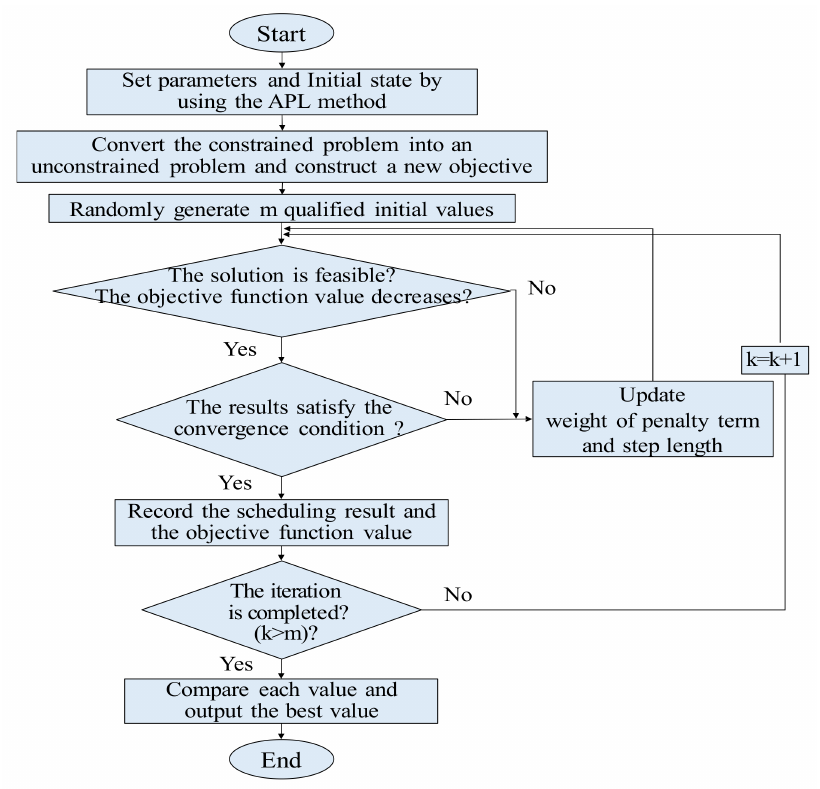
Figure 1. The proposed method of the